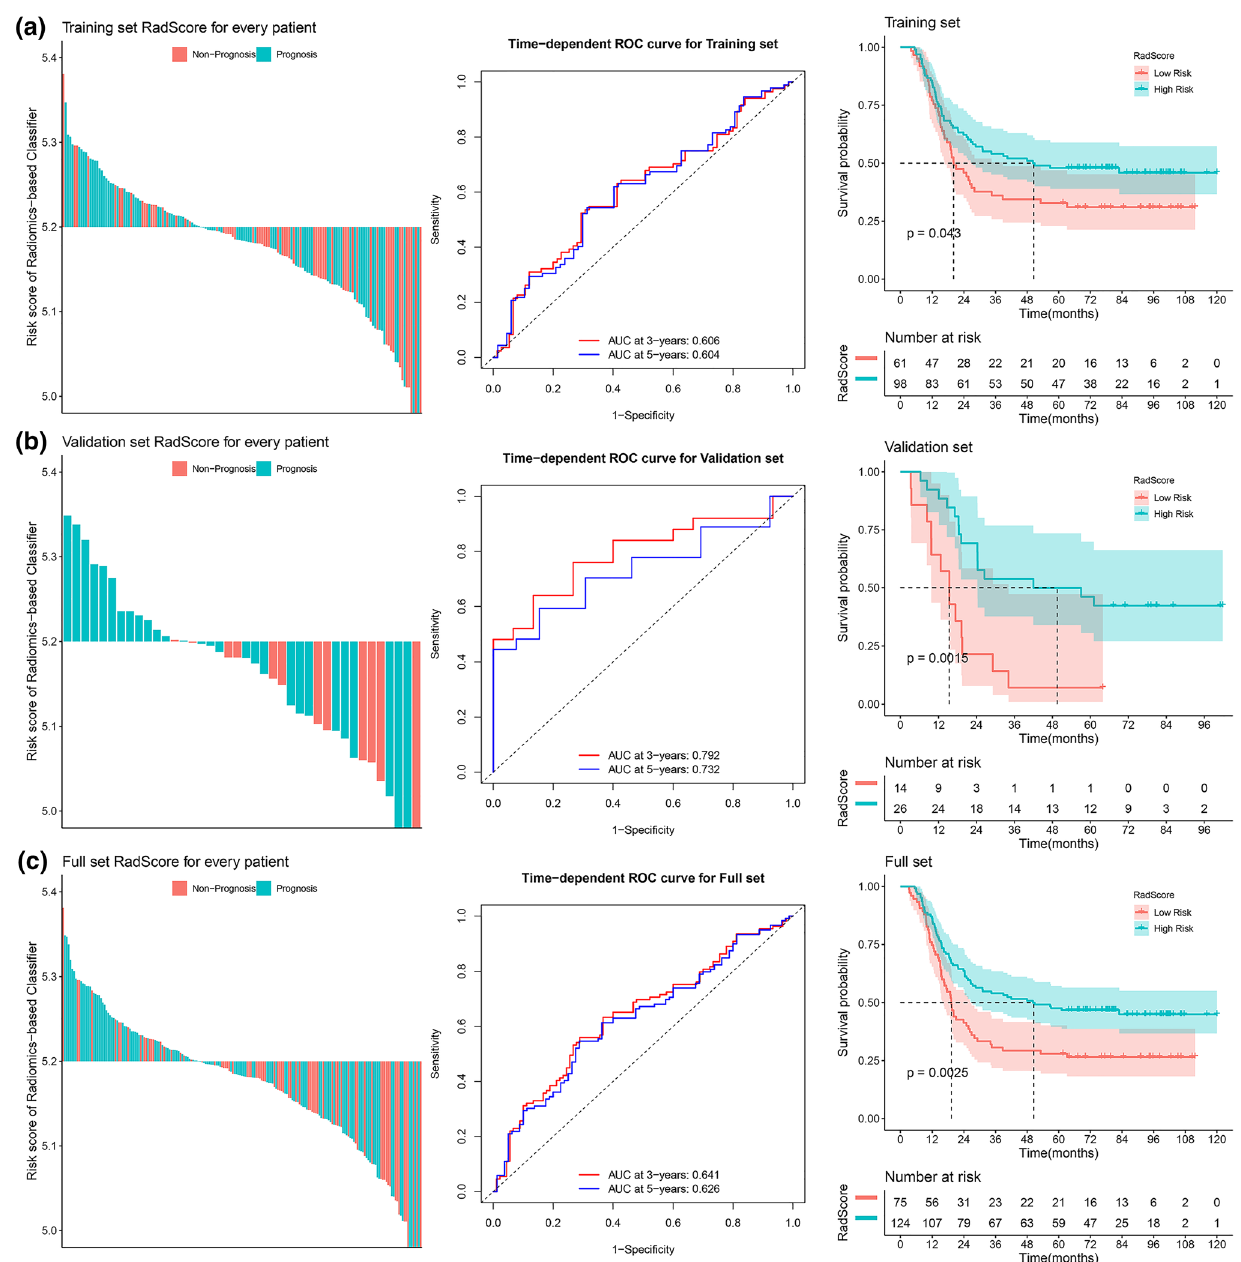
Fig. 3 Risk score by the Rad-Score, time-dependent ROC curves and Kaplan–Meier survival in the training, validation, and whole NPC patients sets. a Training cohort. b Validation cohort. c Combined